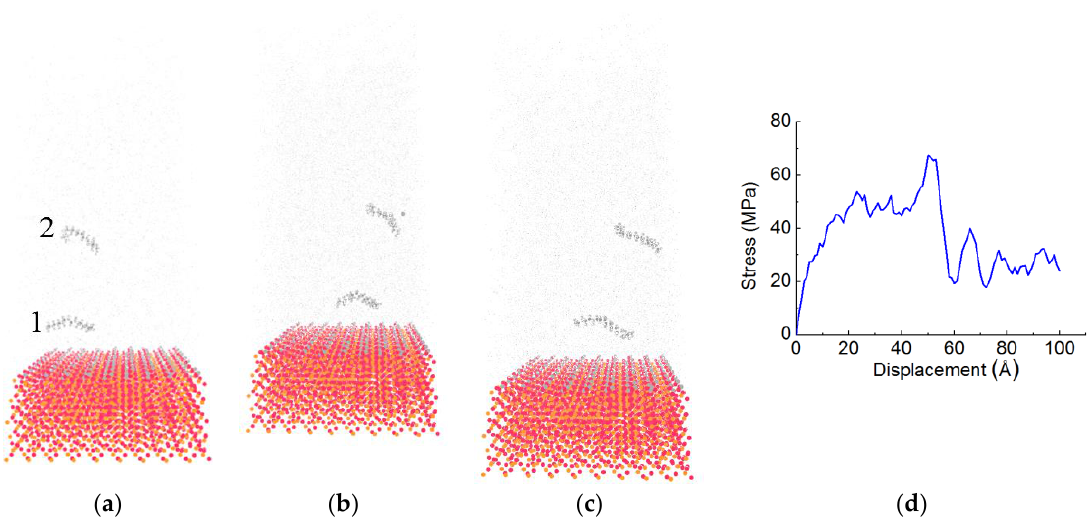
Figure 10. Snapshots of shear simulation of PE(150 – 40)/S interface at various displacements: ( a ) 2 Å , ( b ) 50 Å , ( c ) 100 Å , and ( d ) the stress curve.